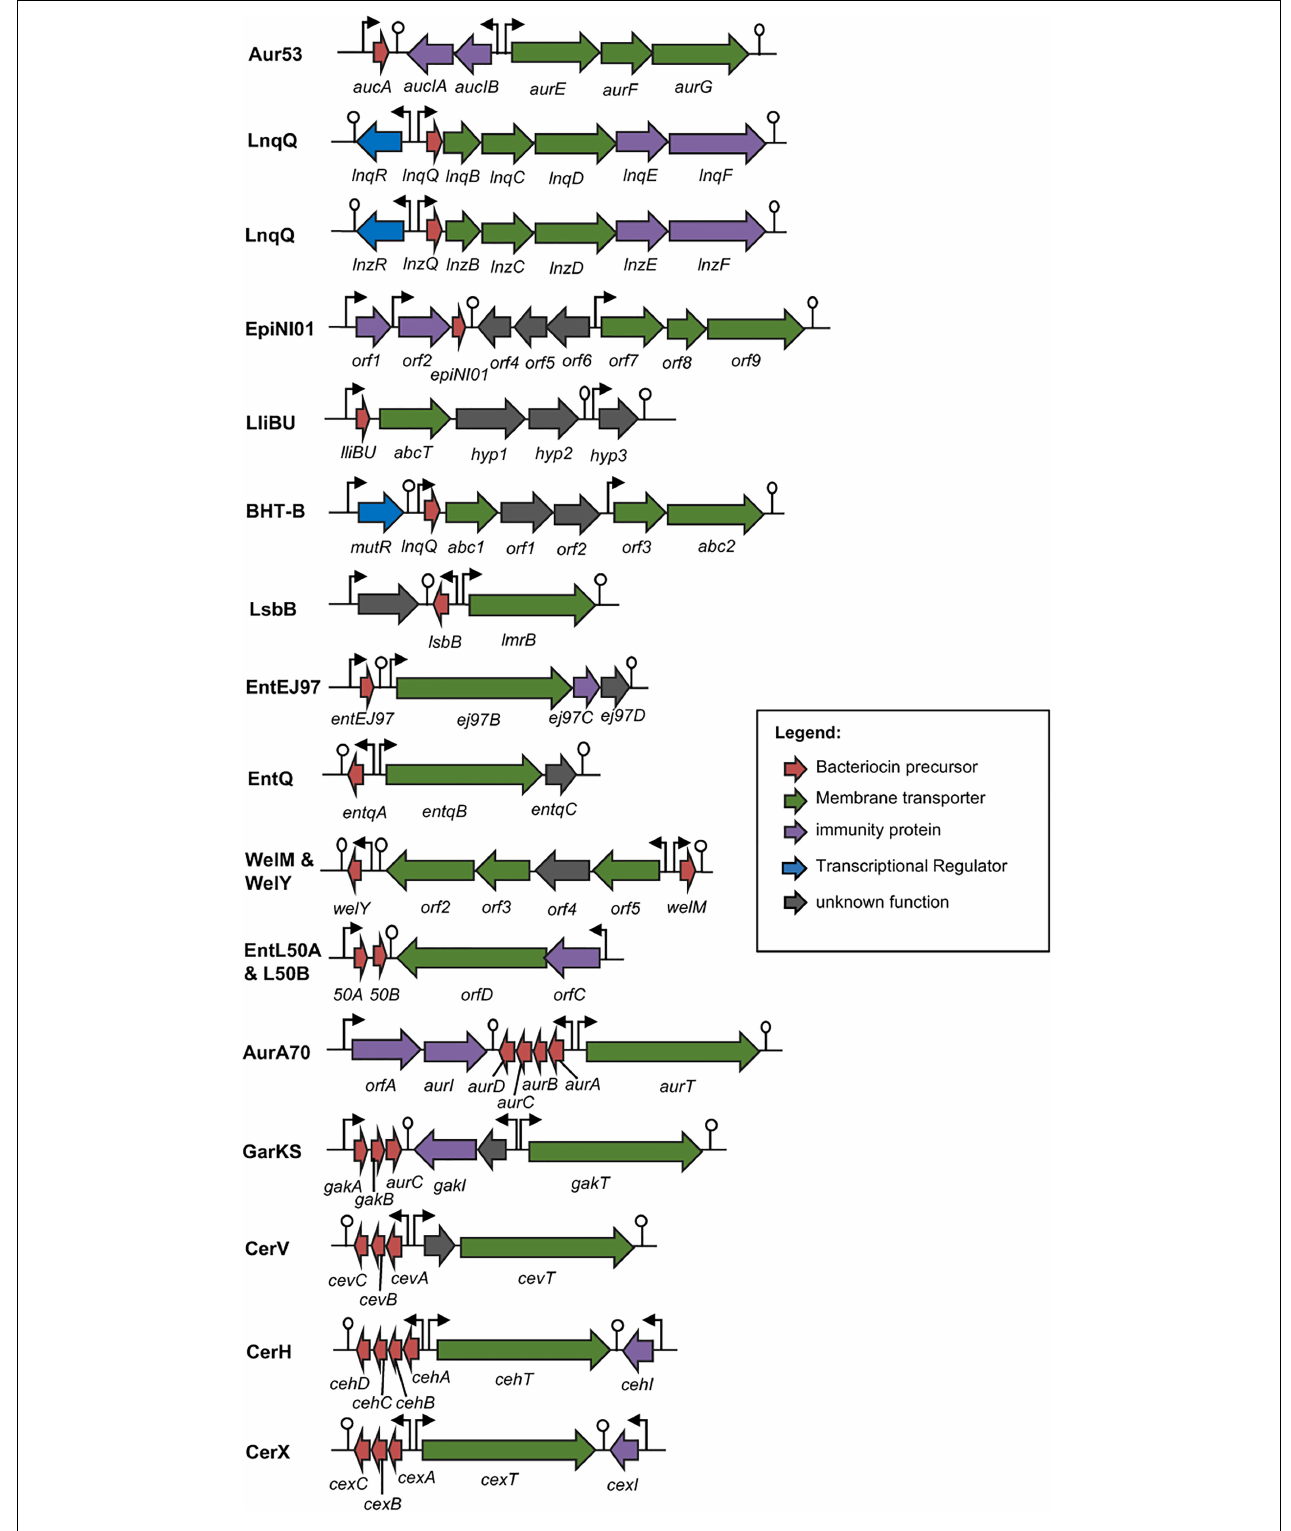
FIGURE 4 | Biosynthetic gene cluster of leaderless bacteriocins. Genes are color coded based on their known and putative functions as indicated. Abbreviation of bacteriocins are shown in the legend of Figure 3 . The bent arrows and lollipop symbols represent putative promoters and putative terminators, respectively. Figures are not drawn in